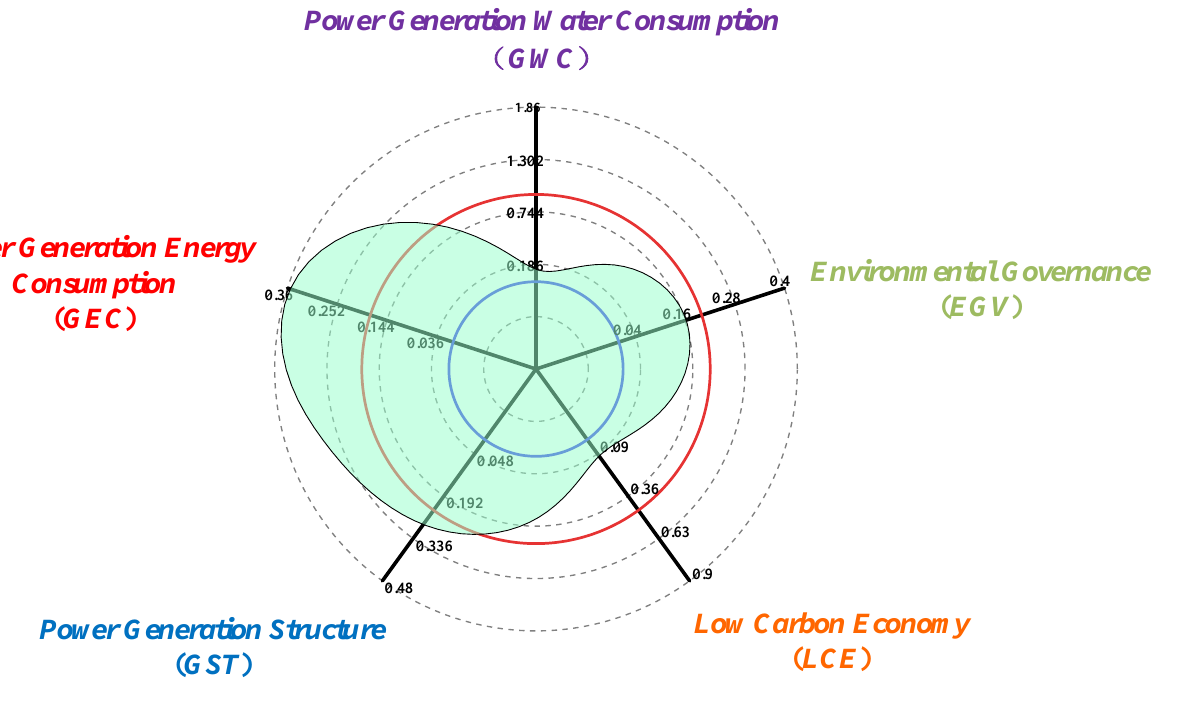
Figure 5. Radar diagram of the importance of the first-level indicators of the carbon emission system of coal power samples.